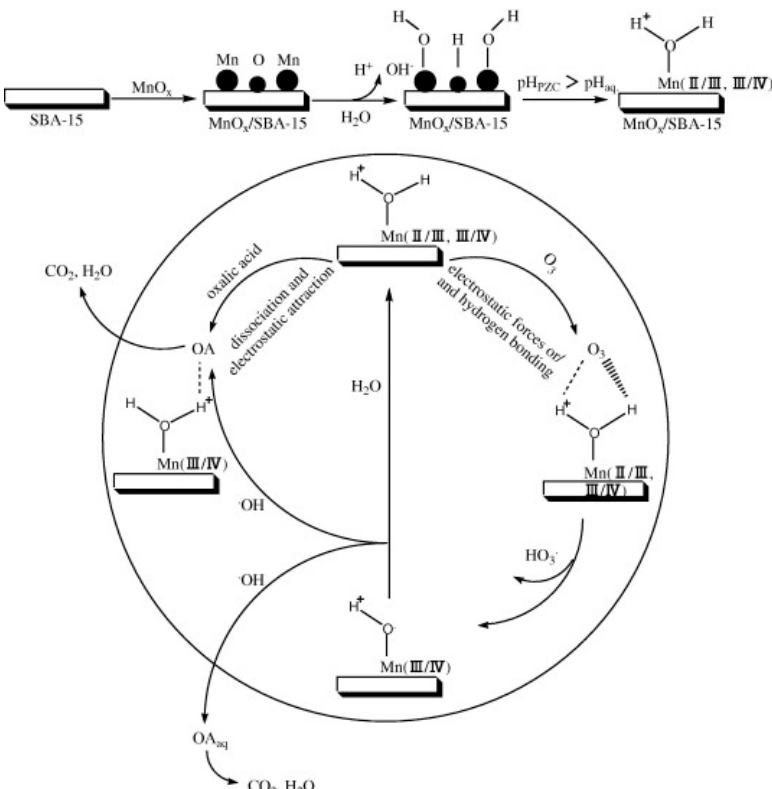
Figure 10. Proposed reaction route for oxalic acid (OA) removal in O 3 /MnO x /SBA-15.